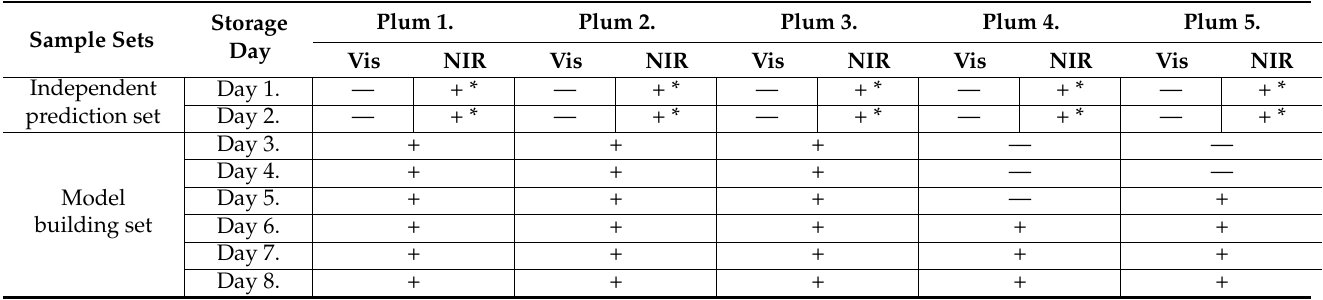
Table 5. Appearance of visible signs of M. fructigena infection on “24 ◦ C Injury” plums stored for 8 d (— plums with no visible sign of infection; and + plums with the visible sign of infection) and the early detectability (*) of the infection with NIR